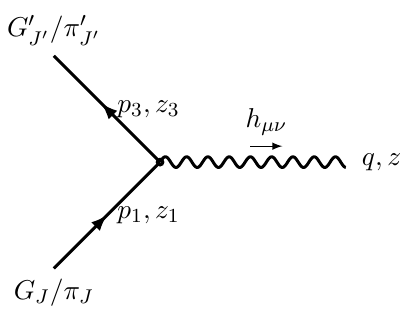
Figure 9 . The three-point interaction between a glueball/meson with spin J , another glue- ball/meson with spin J ′ and a